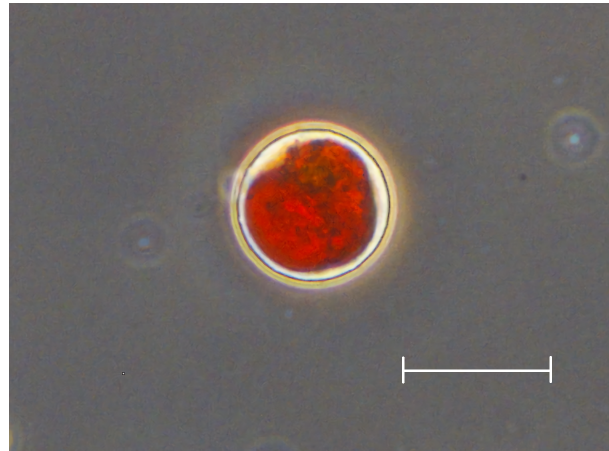
Figure 5. Photograph of snow algal cells observed on the snow sur- face at Site A. An oval red cell with secondary carotenoids, most likely mature spores of Cd. nivalis , which is the dominant species at both sites. Scale bar =